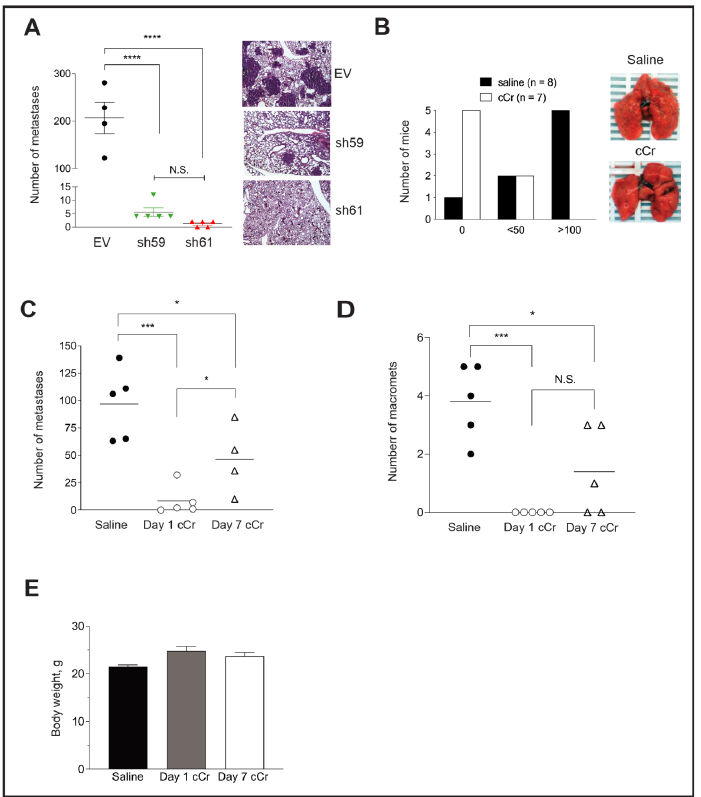
Figure 6. Knockdown of Ckb in the PyMT tumor epithelium or systemic cCr therapy decreases lung metastasis burden. ( A ) PyMT EV, sh59 KD or sh61 KD cells were injected into the tail vein of female FVB/Nj recipients. After 21 days, mice were euthanized and lungs were harvested for metastasis evaluation after lung inflation through the trachea with PBS. The number of metastases was compared across genotypes; the scatter plot shows the burden of individual lungs as the mean ± SEM. Corresponding H&E-stained images of lungs representative of the genotype mean are shown (400 × magnification). Data are representative of two independent experiments. ( B ) EV PyMT cells were injected into the tail vein of female FVB/Nj recipients. The next day, treatment with either vehicle (saline, IP, daily) or cCr (1 g/kg in saline, IP, daily) was initiated. After 21 days, the mice were euthanized, and lungs were harvested after inflation with PBS. The total number of surface metastases was counted under a dissecting scope. Most of the mice treated with cCr (5 of 7) did not develop detectable metastases, although 2 mice in each cohort (2/8, saline and 2/7, cCr) developed fewer than 50 metastases. Only in the saline group did the majority of mice develop metastases throughout the lung, with >100 lesions present (5/8 mice; χ 2 = 7.634, p = 0.022). Images of whole lungs photographed immediately post-dissection are shown. ( C , D ) Comparison of total metastases present per lung ( C ), or the number of macro-metastases per lung ( D ) when mice were treated with vehicle, or when cCr was administered at either day 1 (Day 1 cCr) or when cCr therapy began at day 7 after the tail vein injection (Day 7 cCr). All lungs were harvested at day 21 post-injection. ( E ) The mean bodyweight of the mice treated with saline (vehicle) or cCr from panels ( C , D